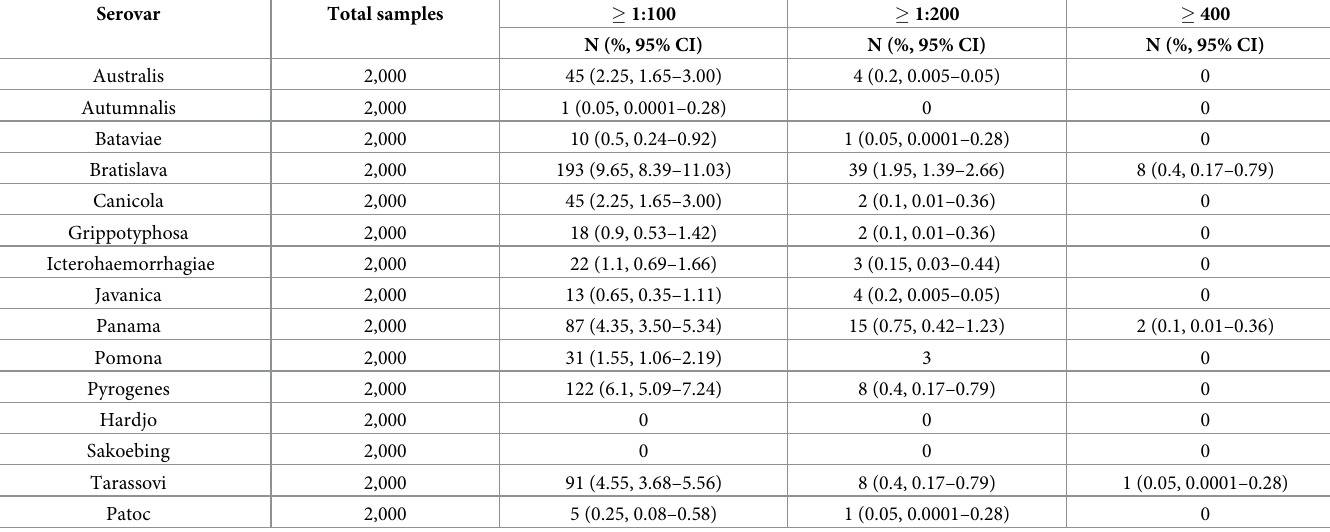
Table 3. MAT results for Leptospira serovars in pigs by using 3 cutoff titers.